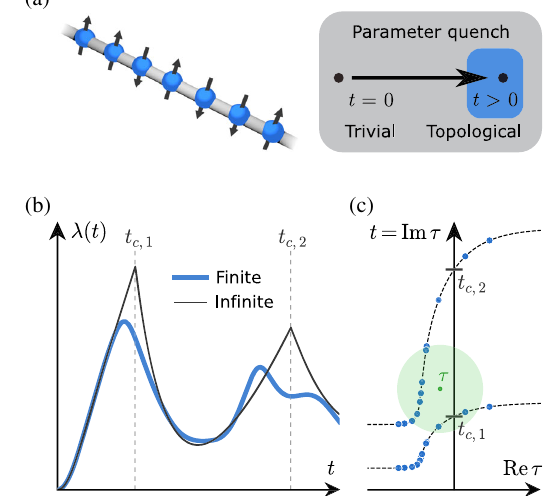
FIG. 1. Dynamical phase transitions. (a) A sudden quench of the system parameters causes a dynamical phase transition in a quantum spin chain with L sites. (b) In the thermodynamic limit, such phase transitions give rise to singularities in the rate function at the critical times, t c; 1 ; t c; 2 … [see Eqs. (1) and (2) for definitions]; however, in finite-size systems, they are smeared out. (c) The singularities in the rate function are associated with the zeros (circles) of the Loschmidt amplitude in the complex-time plane. In the thermodynamic limit, they form continuous lines, and the real critical times are given by the crossing points with the imaginary axis. We determine the zeros of the Loschmidt amplitude from the Loschmidt cumulants evaluated at the basepoint τ